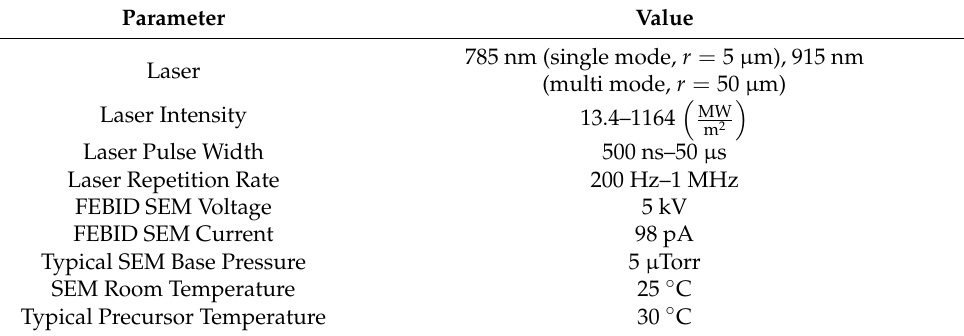
Table 2. System Physical